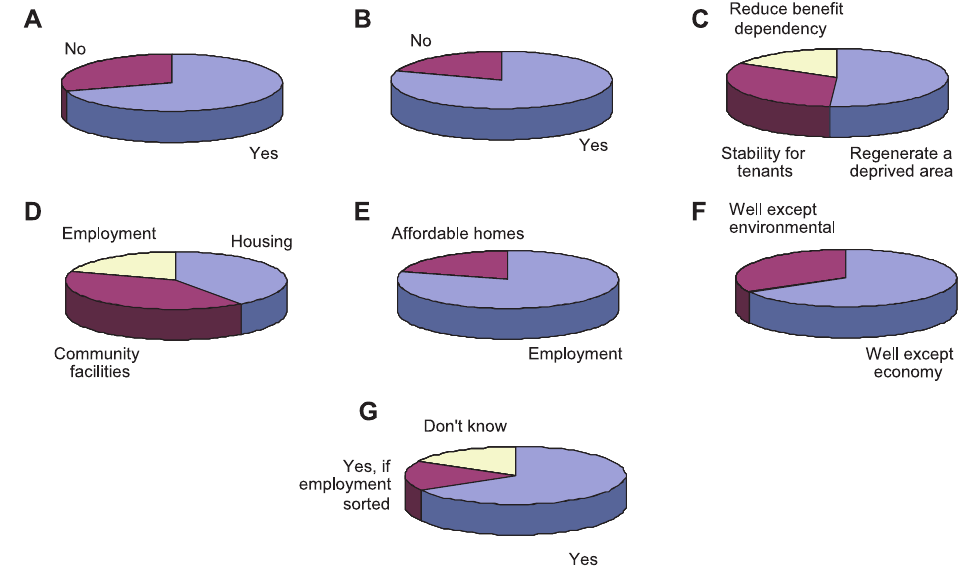
Fig. 4. Castlefields regeneration programme and sustainable communities. Charts denote the propor- tion of responses against each interview question. A-G represent responses to the following questions: (A) Is the Castlefields community engaged in regeneration programme? (B) Does the community feel included in the regeneration programme? (C) What can be achieved through Castlefields